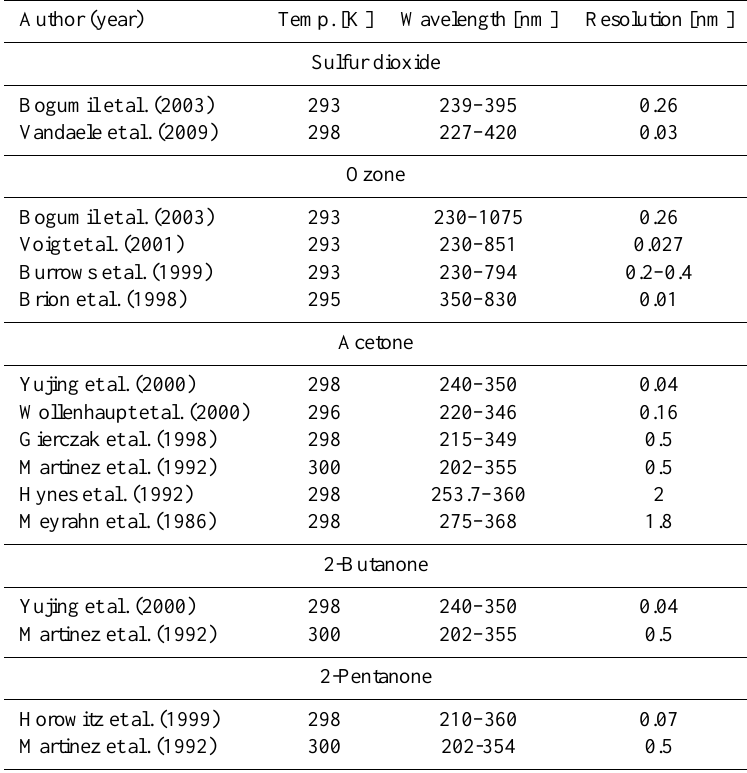
Table 1. Instrumental parameters of literature absorption cross